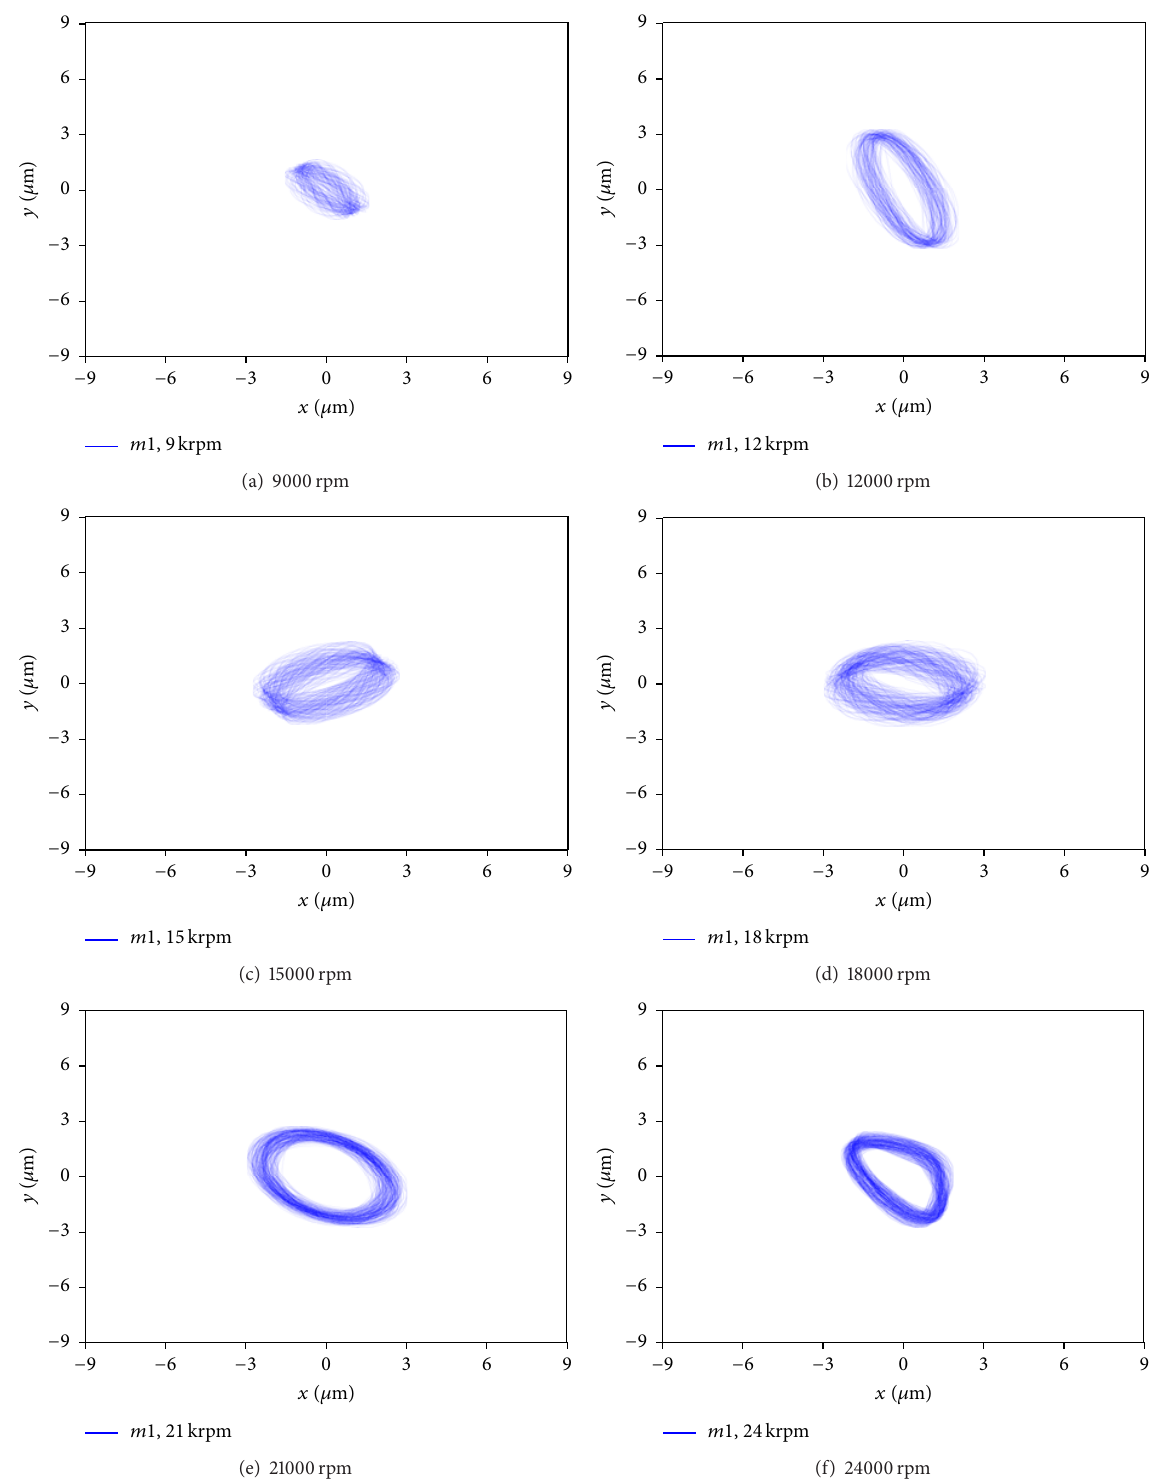
Figure 7: Orbits of the front bearing with an attached unbalance mass m 1 =